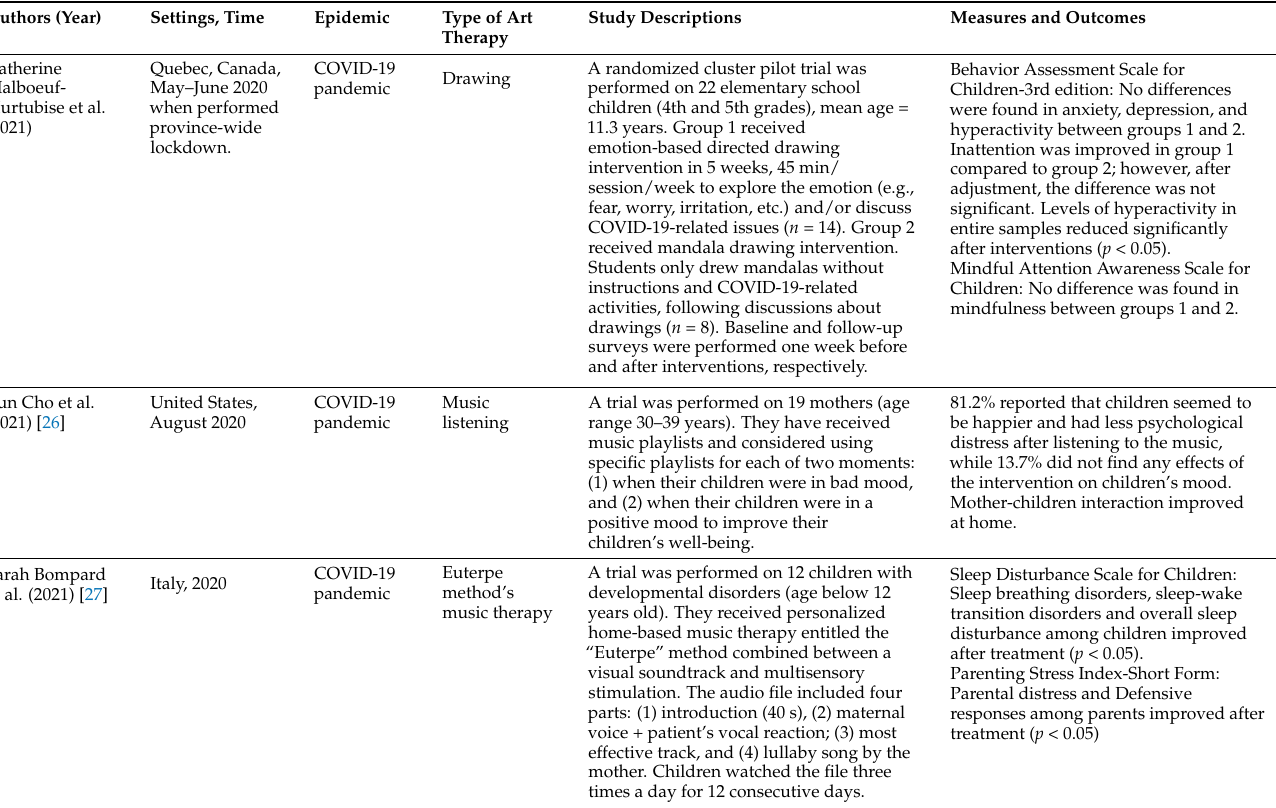
Table 1. Summary of the selected